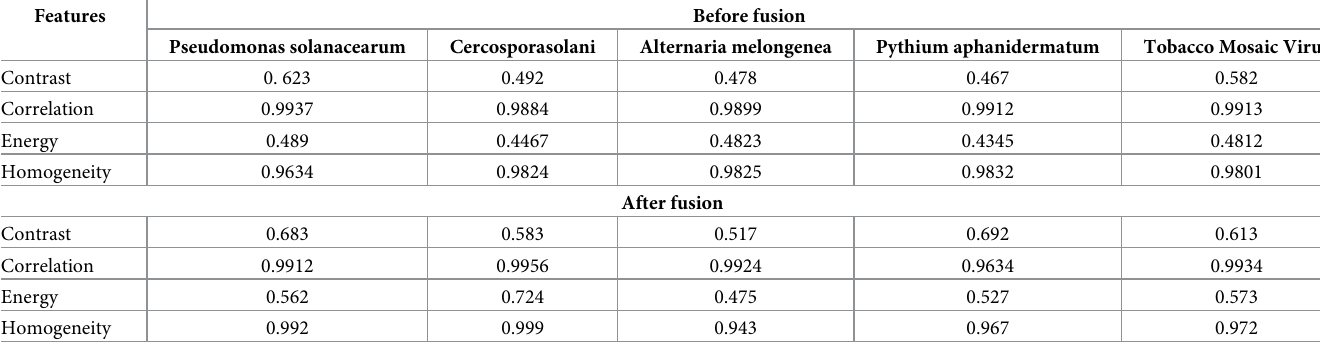
Table 4. Texture features of brinjal leaf images before and after fusion using